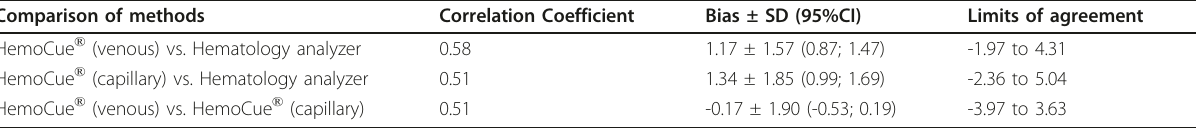
Table 2 Correlation, bias, and limits of agreement between hemoglobin level using HemoCue ® and automated hematology analyzer Comparison of methods Correlation